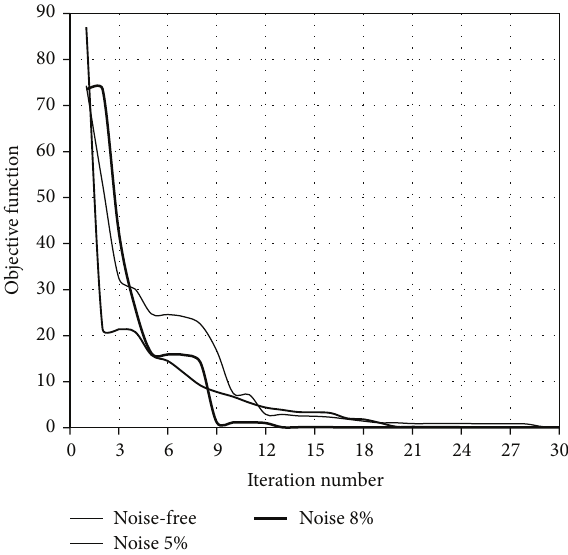
Figure 6: Convergence history of the ICA for the five-story shear frame for scenario II.